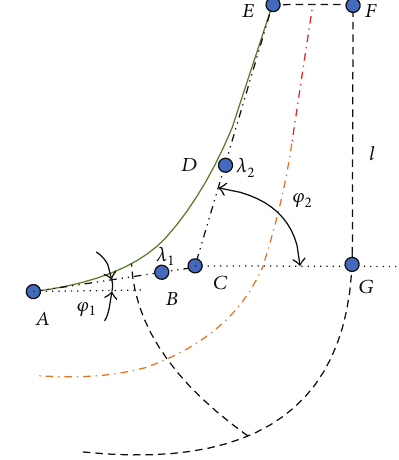
Figure 1: Main dimensions of centrifugal pump’s impellers (unit: mm). Figure 2: Meridional section of the pump impeller. Table 1: Decision variables and their